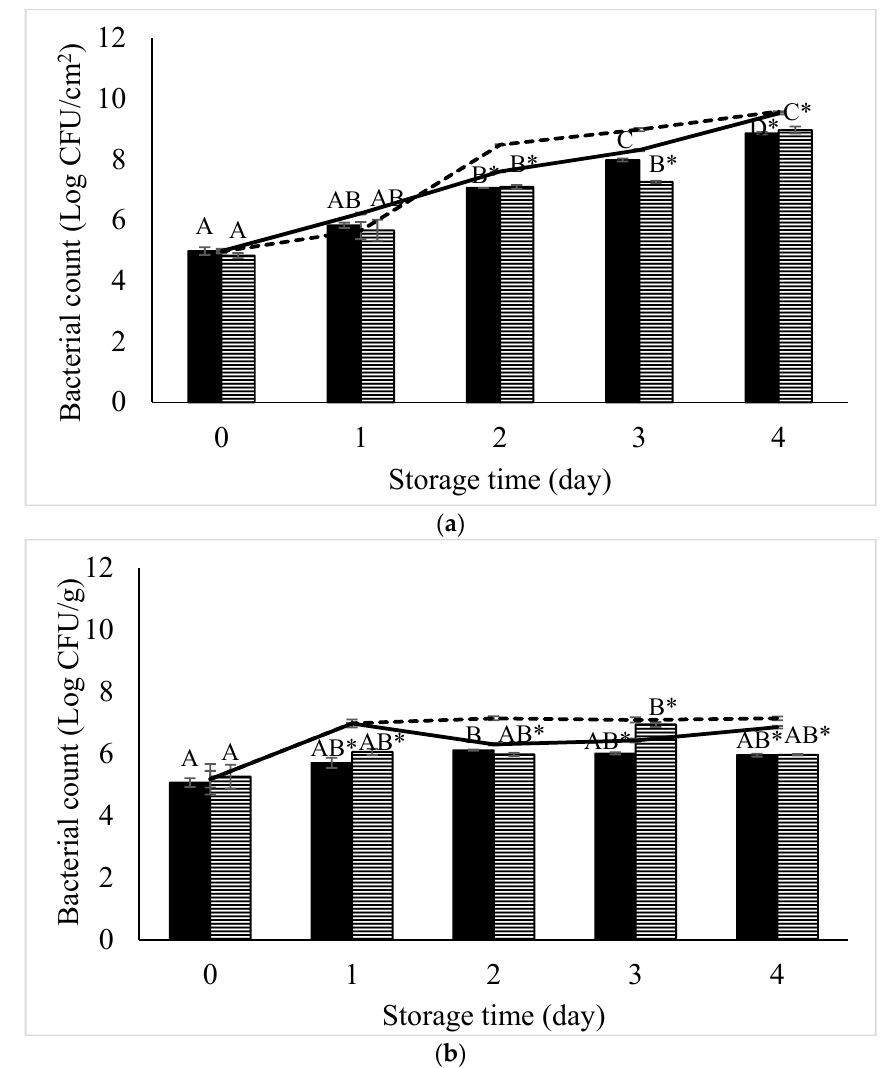
Figure 4. Recovery of S. Enteritidis ( ) and S. Typhimurium ( ) artificially contaminated in ( a ) chicken meat and ( b ) sunflower sprouts treated with a phage cocktail and stored at 4 °C for 4 days. Control (non-phage cocktail treated) of S. Enteritidis and S. Typhimurium inoculated on both samples presented by solid line and dashed line, respectively. Bars represent the mean standard deviation ( n = 3). The sign (*) on the bars indicates significant differences ( p < 0.05) of bacterial count between control and treatment during storage time for a given Salmonella strain. Different uppercase letters on the bars indicate significant differences ( p < 0.05) of bacterial count among days of storage for a given Salmonella strain. Table 7. Lysis ability of a phage cocktail and individual phages included in a phage cocktail preparation on S. Enteritidis (SE) and S. Typhimurium (ST) after being treated with a phage cocktail. Lysis Ability a Cocktail KP4 KP5 KP50 Treatment Phage Titer (PFU/mL)